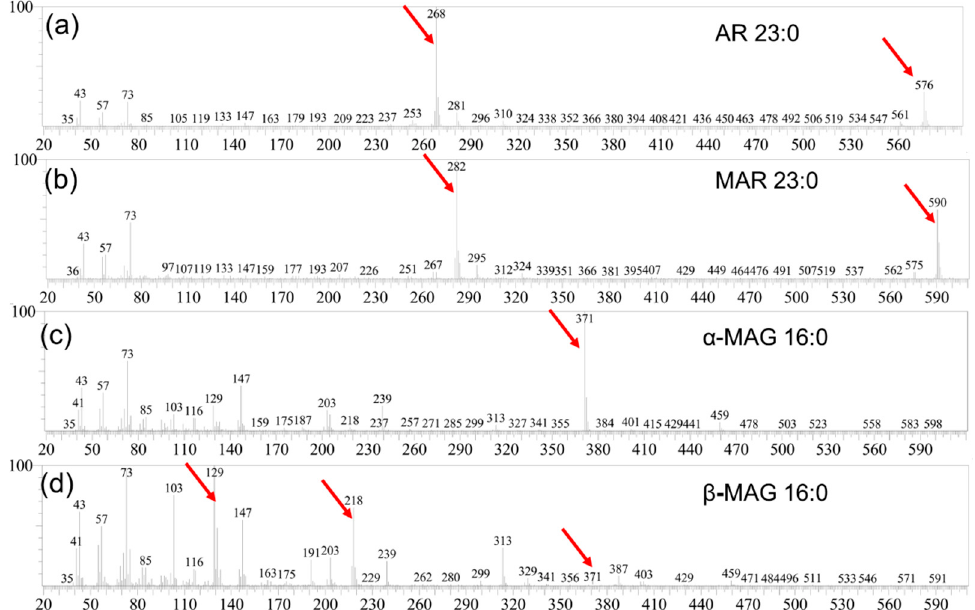
Figure 3. Identification of saturated ARs, MARs and MAGs present in the lipids by GC-MS of their bis-TMSi derivatives: mass spectra of AR 23:0 ( a ), MAR 23:0 ( b ), α -MAG 16:0 ( c ) and β -MAG 16:0 ( d ).